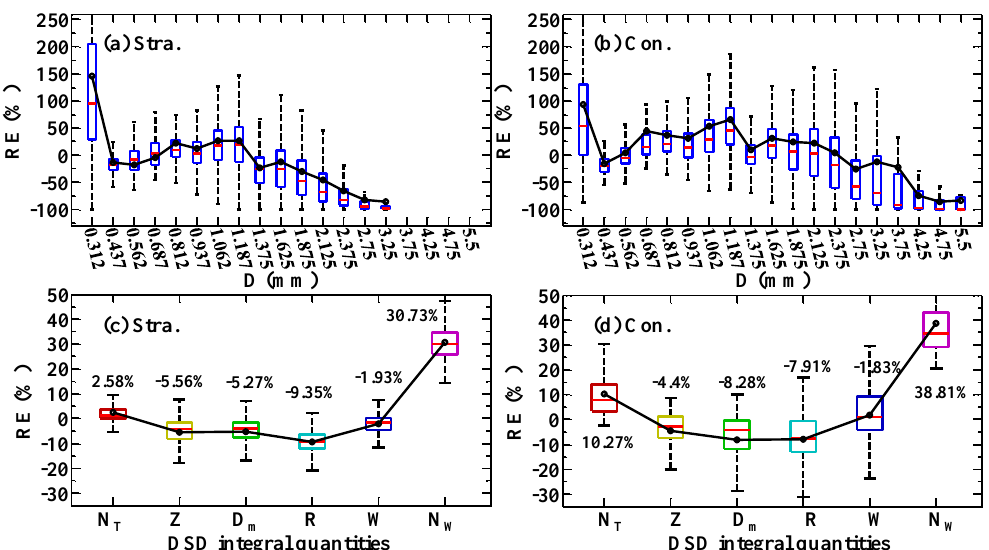
Figure 14. Relative errors (REs) of the gamma-fitted results. ( a ) and ( b ) are RE boxplots of raindrop number concentration in different diameter classes for two rain types. ( c ) and ( d ) are RE boxplots of the DSD-derived rainfall quantities [raindrop total number concentration N T (m − 3 ), reflectivity Z (dBZ), mass-weighted mean diameter D m (mm), rain rate R (mm h − 1 ), rainwater content W (g m − 3 ), generalized intercept parameter log 10 ( N w ) (m − 3 mm − 1 )] for two rain types. The black lines with circles in subgraphs represent the averages.